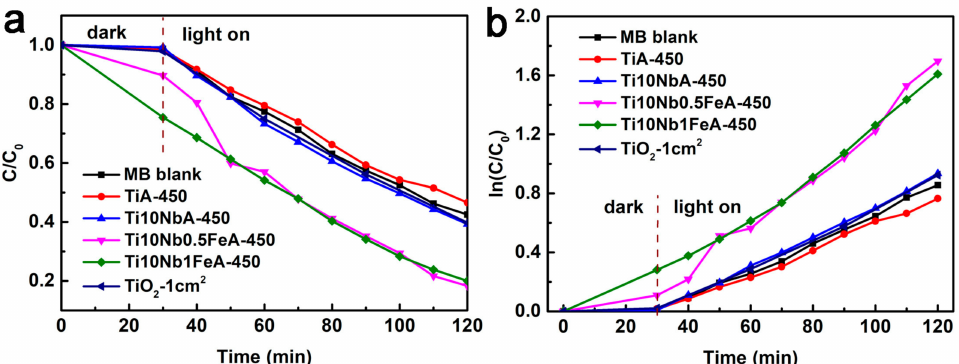
Figure 10. Photocatalytic degradation of MB under solar ( λ > 400 nm) irradiation. ( a ): Ti, Ti10Nb and Ti10NbxFe alloy-based nanotubes under 450 ◦ C heat treatment in air and TiO 2 film with P25; ( b ) reaction kinetics (ln(C/C 0 ) = − k app ∗ t) of photoreaction, where k is the apparent first-order rate